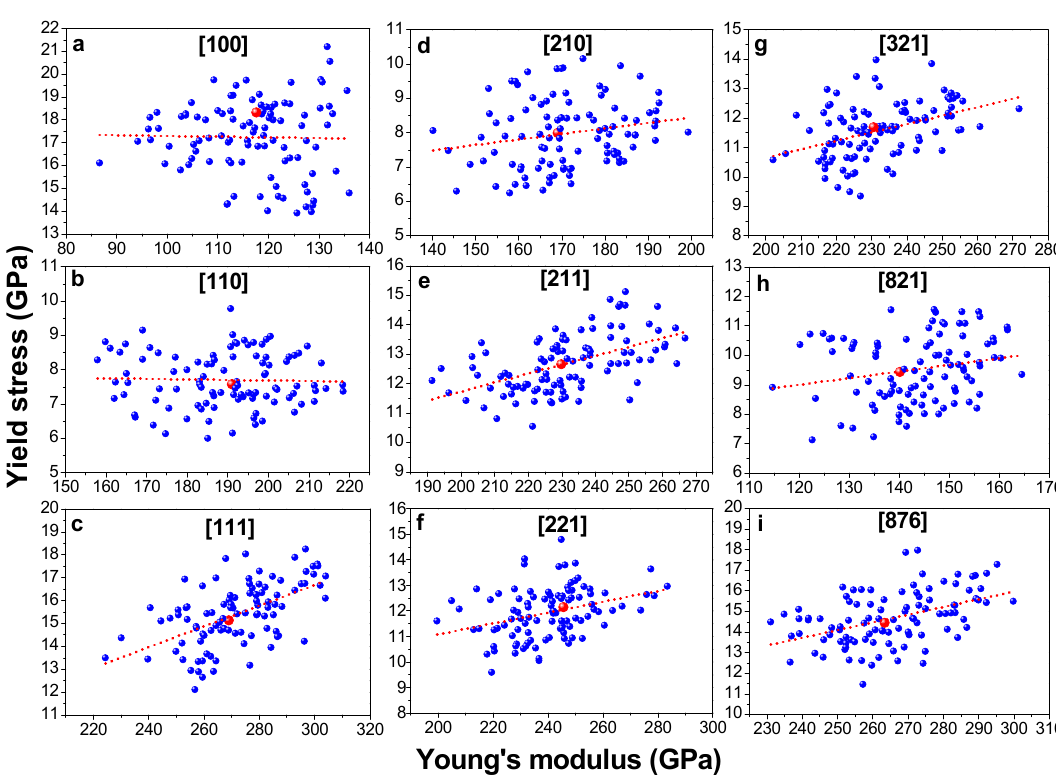
Figure 5. Yield stress as a function of Young’s modulus of the single crystal HEA samples with various element compositions. ( a – i ) Results of different crystallographic orientations, including [100], [110], [111], [210], [211], [221], [321], [821], and [876]. along different orientations. The red point denotes the result of the equiatomic sample.